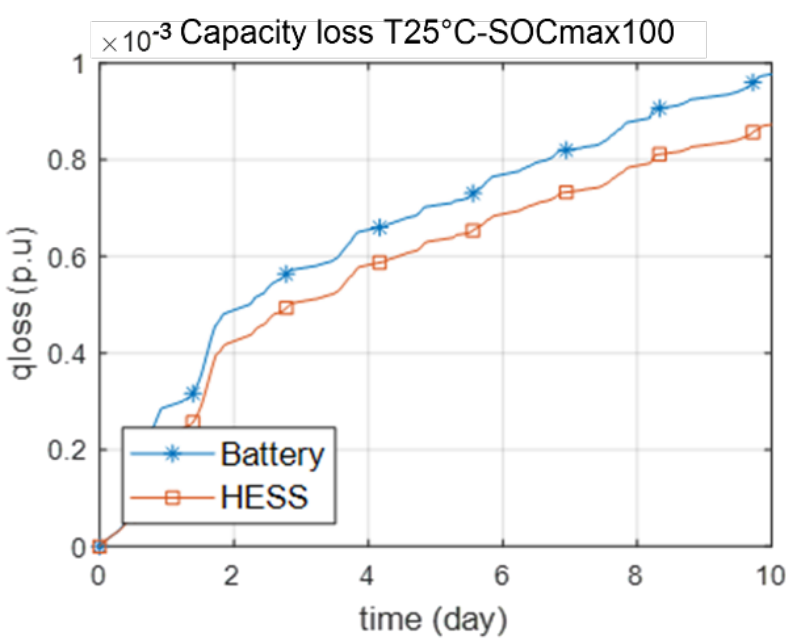
Figure 12. Battery capacity loss in HESS versus classical strategy 1.